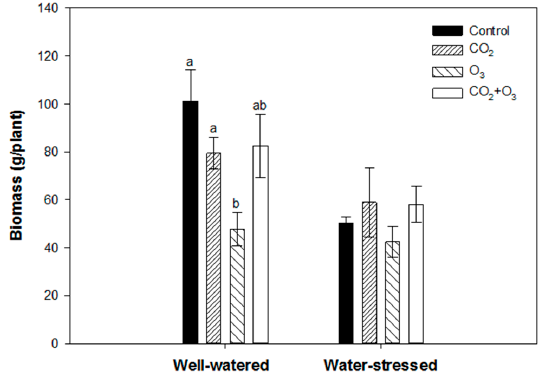
Figure 4. Biomass of canola exposed to CO 2 , O 3 and CO 2 + O 3 under well-watered and water-stressed conditions after four weeks. For the same treatment, different letters show statistically significant differences ( p < 0.05 ).